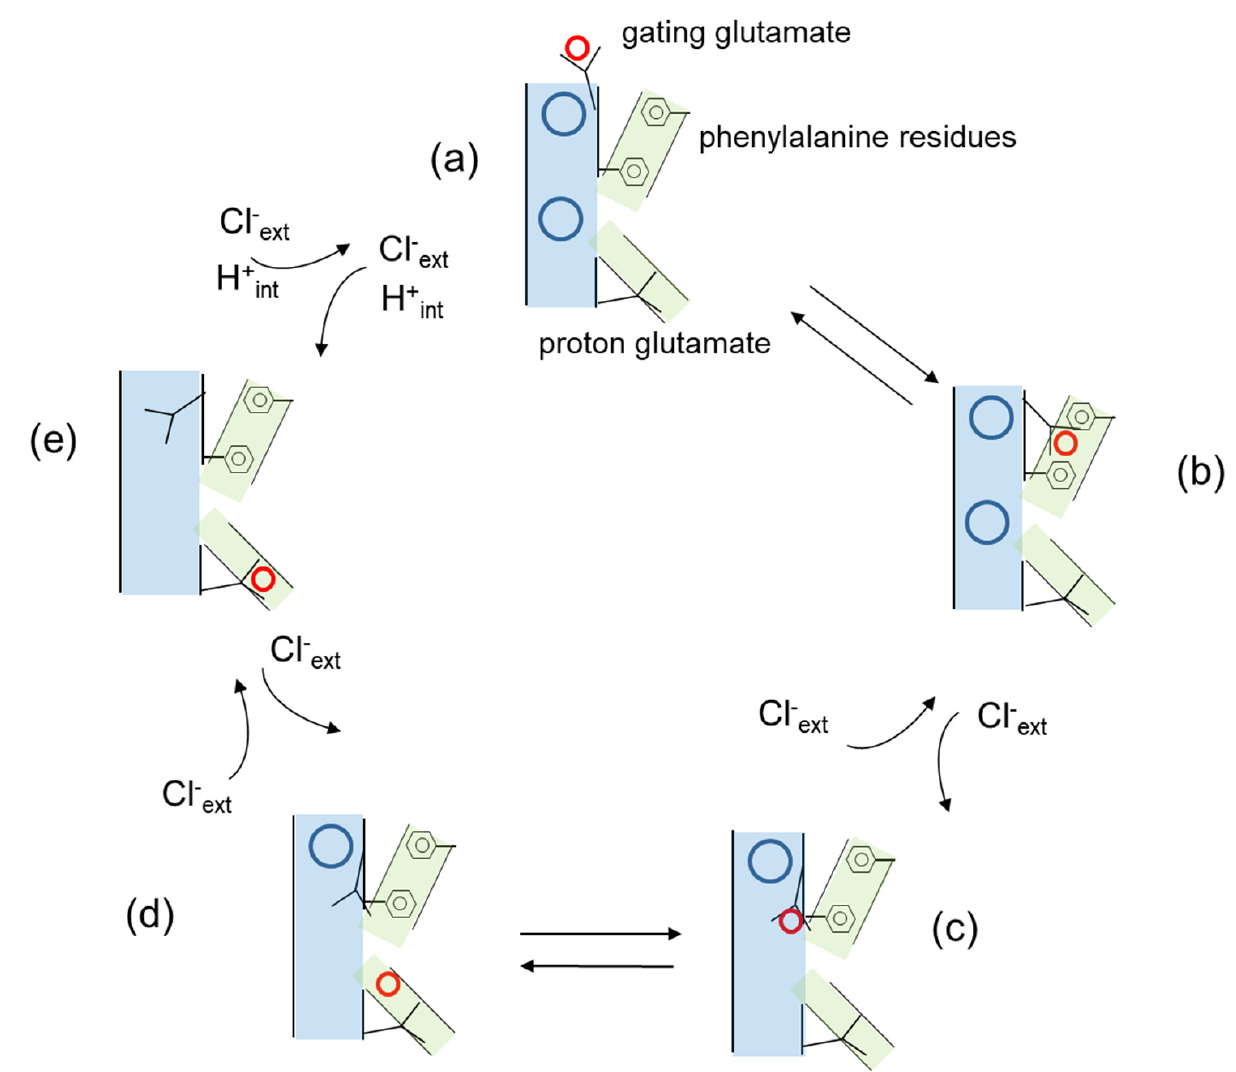
Figure 2. Simplified model of the transport cycle of CLC transporters based on the work of Leisle et al. [27]. Cl − ions at the external and central binding sites are represented as blue circles, H + are represented as red circles, the anion permeation pathway is shown in pale blue, the H + permeation pathway in green. The gating and proton glutamates and the phenyalanine residues are explicitly indicated in the figure. ( a ) The gating glutamate is oriented towards the extracellular space and its side chain protonated. Cl − ions are present at both the external and central binding site. ( b ) The protonated gating glutamate rotates towards the interior of the protein along a pathway defined by two phenylalanine residues. ( c ) The protonated gating glutamate continues its movement towards the central binding site displacing a Cl − ion towards the extracellular space. ( d ) The H + dissociates from the side chain of the gating glutamate. ( e ) The H + binds the proton glutamate and the side chain of the gating glutamate moves upwards to occupy the external anion binding site displacing a second Cl − ion. Not explicitly indicated is an intermediate state following proton release to the cytosolic side in which Cl − ions from the internal side have access to the permeation